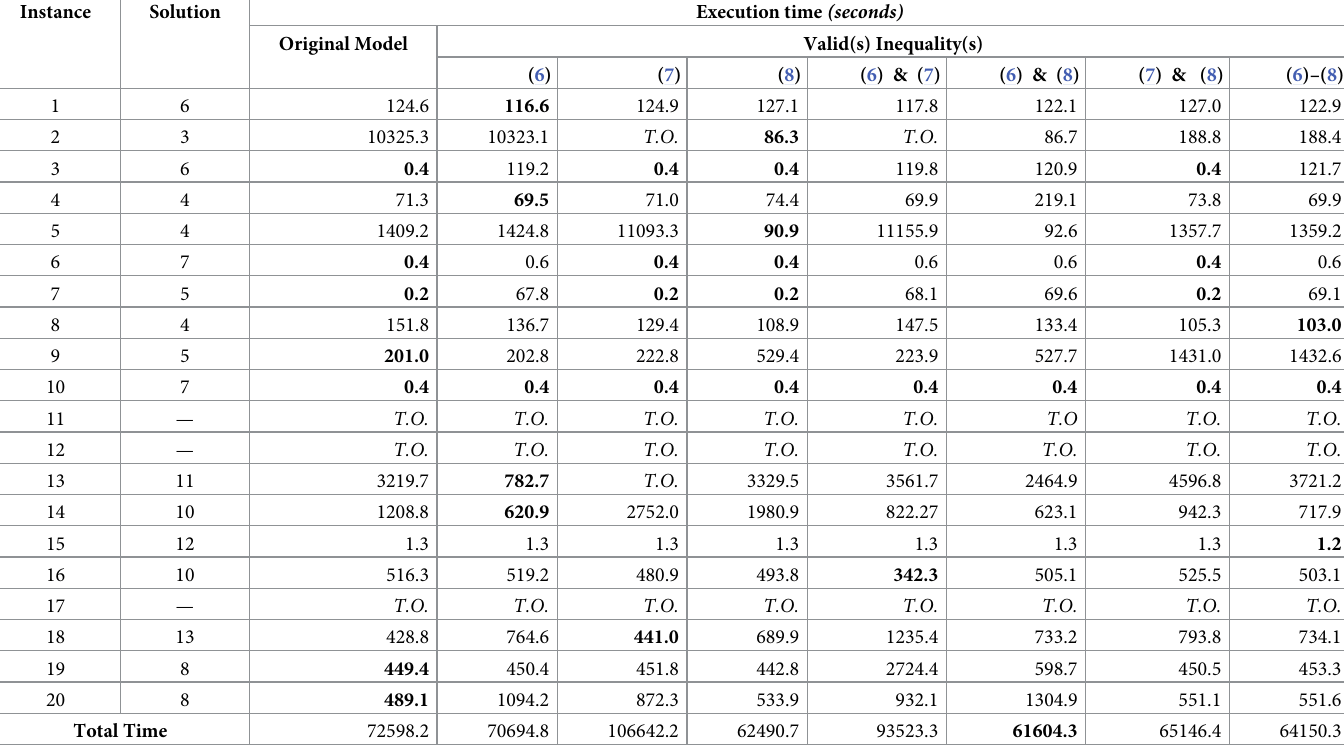
Table 7. Experimental results for Class 3 of the bwmv instances without rotations with n = 20 and n = 40, applying the different families of valid inequalities to the set-covering